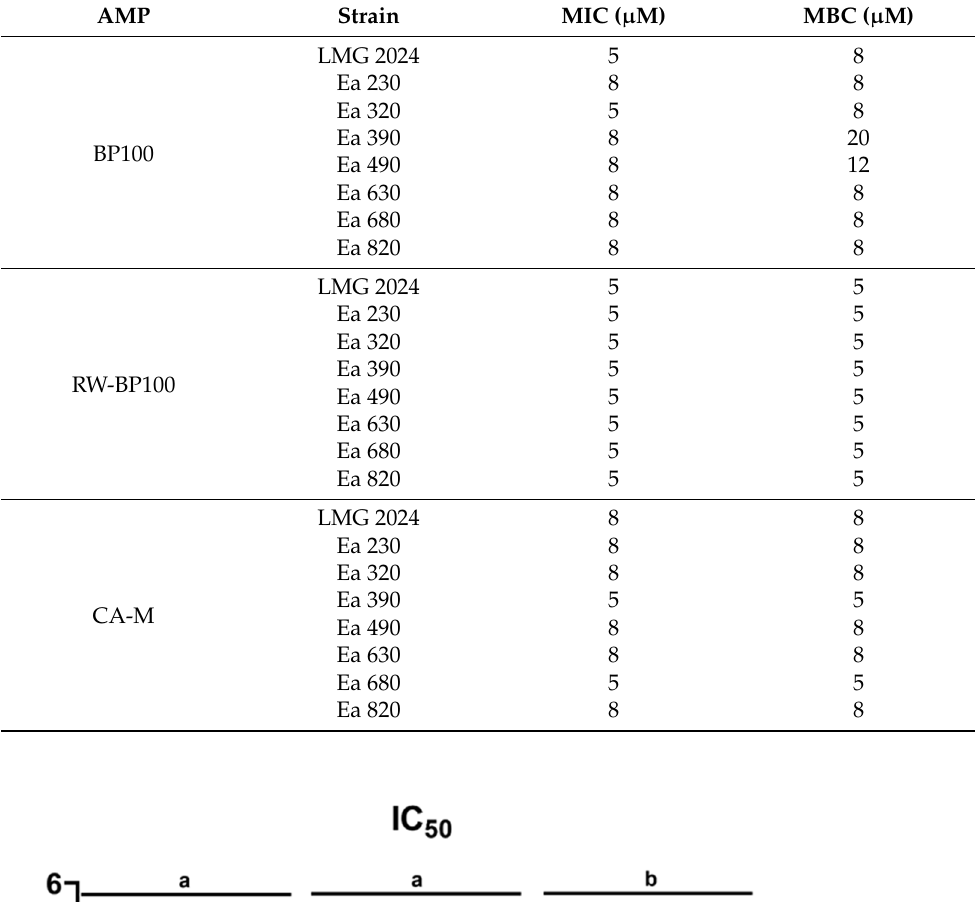
Table 3. AMPs values of minimal inhibitory concentration (MIC), minimal bactericidal concentration (MBC) and obtained for the eight Erwinia amylovora strains ( n = 3).